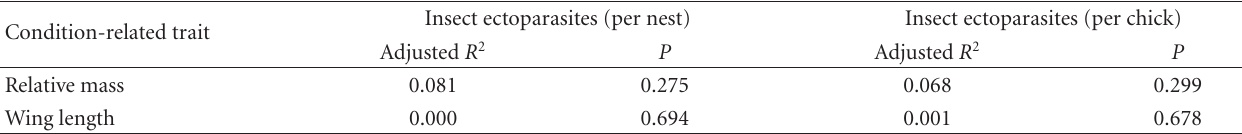
Table 1: Results of multiple linear regression analyses between insect ectoparasite abundance (quantified per nest or per chick) and great tit o ff spring condition quantified using two condition-related traits (d.f. = 19 in all cases).